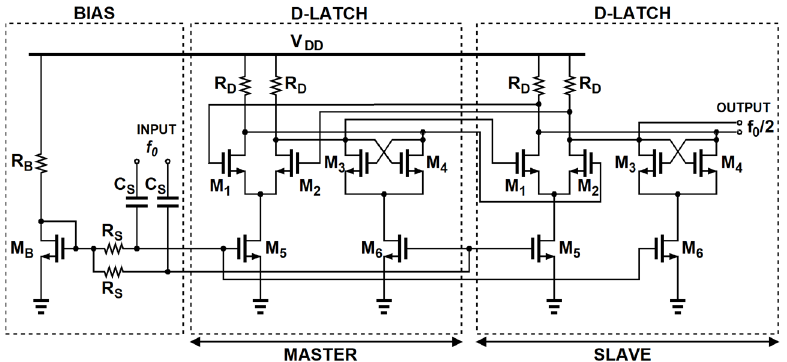
Figure 5. Schematic of the divider stage based on static complementary metal ‐ oxide–semiconductor